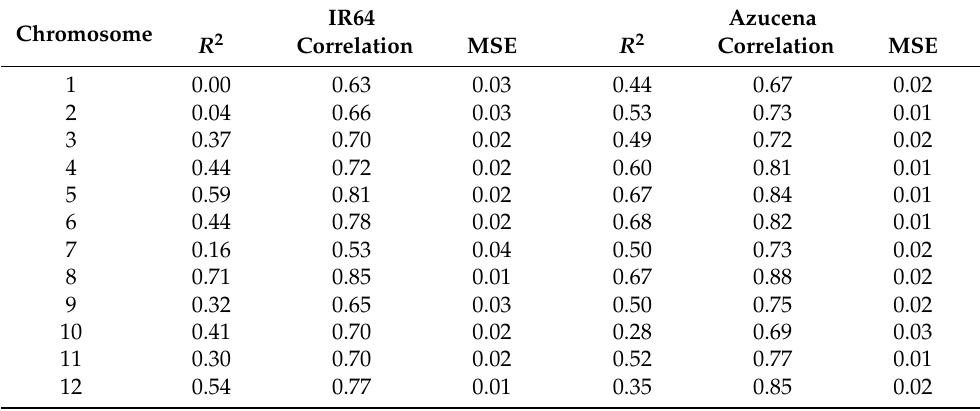
Figure 7. Shap values and contributions of features CG, CHG, and CHH to the prediction of recombination rates, using IR64 and Azucena data: ( a ) Shap summary plot of features for the IR64 variety; ( b ) Shap summary plot of features for the Azucena variety; ( c ) Shap values for the IR64 variety; and ( d ) Shap values for the Azucena variety. Table 1. Performance of chromosome recombination rates predictions of IR64 and Azucena rice varieties using the Extra Trees model trained with CHH methylation